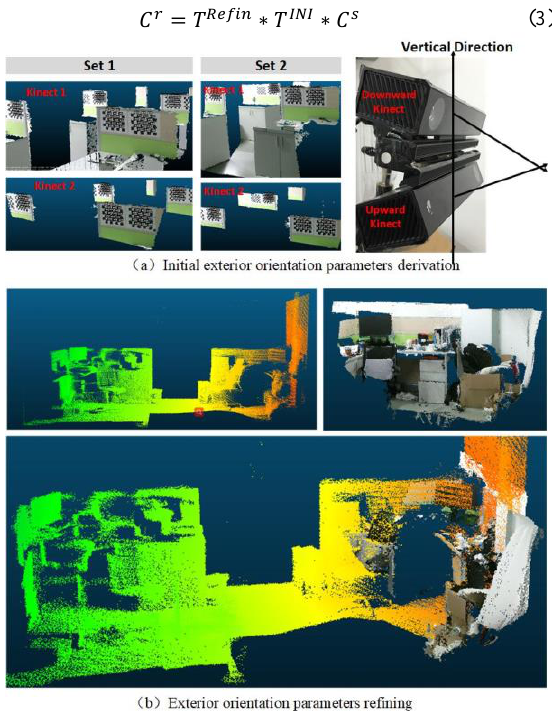
Figure 2. Exterior orientation calibration for stereo